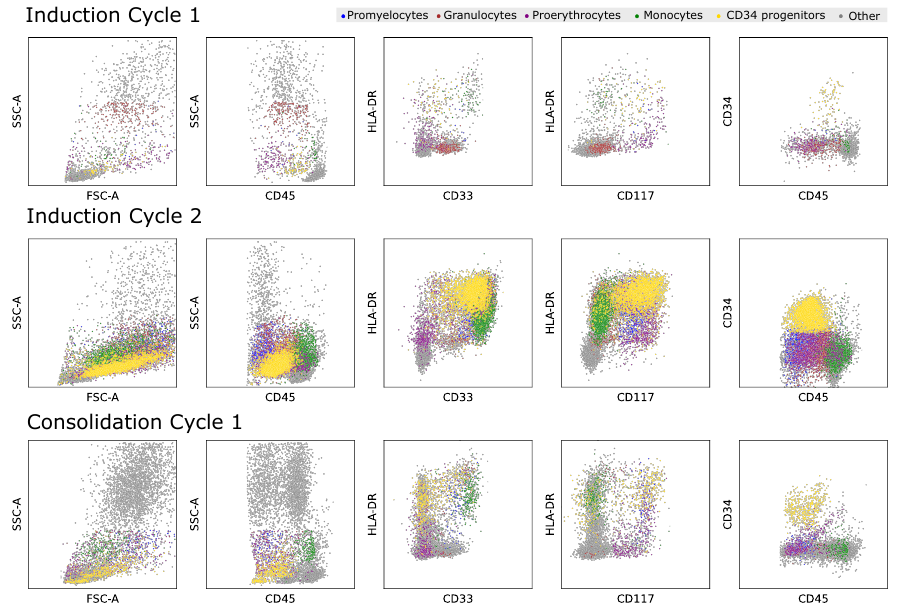
Figure A2. FCM samples of one patient from different stages during therapy are compared. Therapy mainly affects the density of different cell populations. Colors of events falling into the bermude area represent promyelocytes (blue), granulocytes (brown), proerythrocytes (purple), monocytes (green), CD34 progenitors